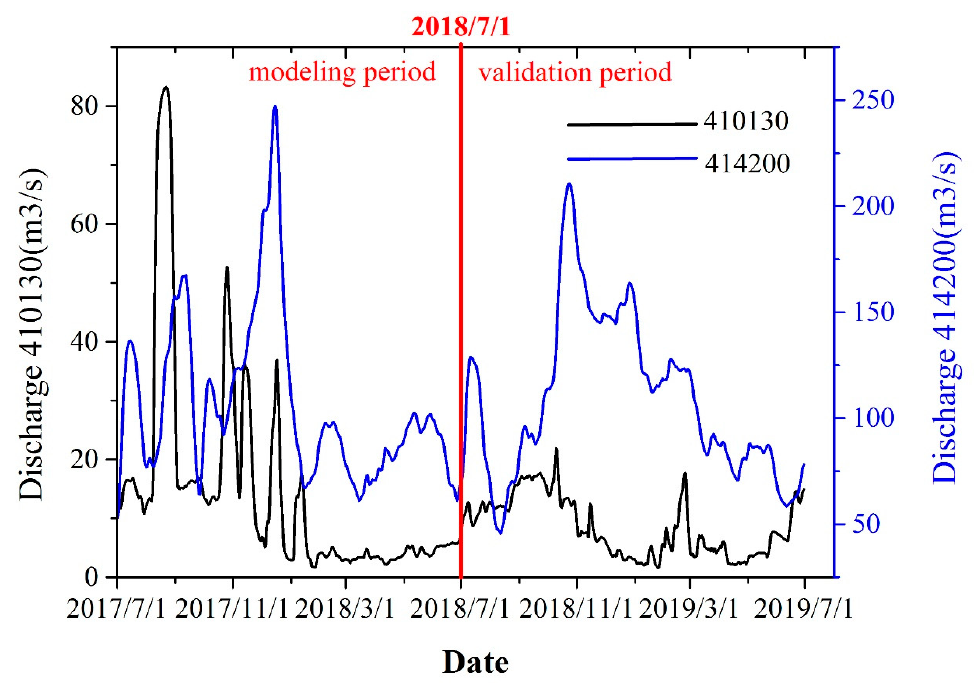
Figure 2. Observed daily discharge at Gauges 410130 and 414200 for the 2017 and 2018 water years.